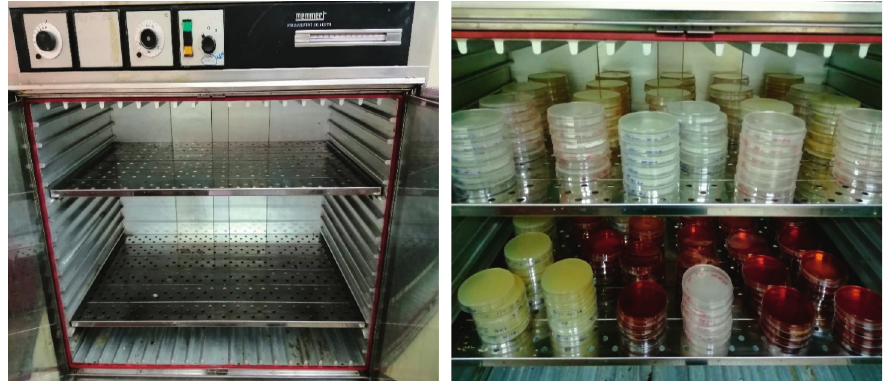
Figure 3: Plates incubated in a Memmert incubator for microbial